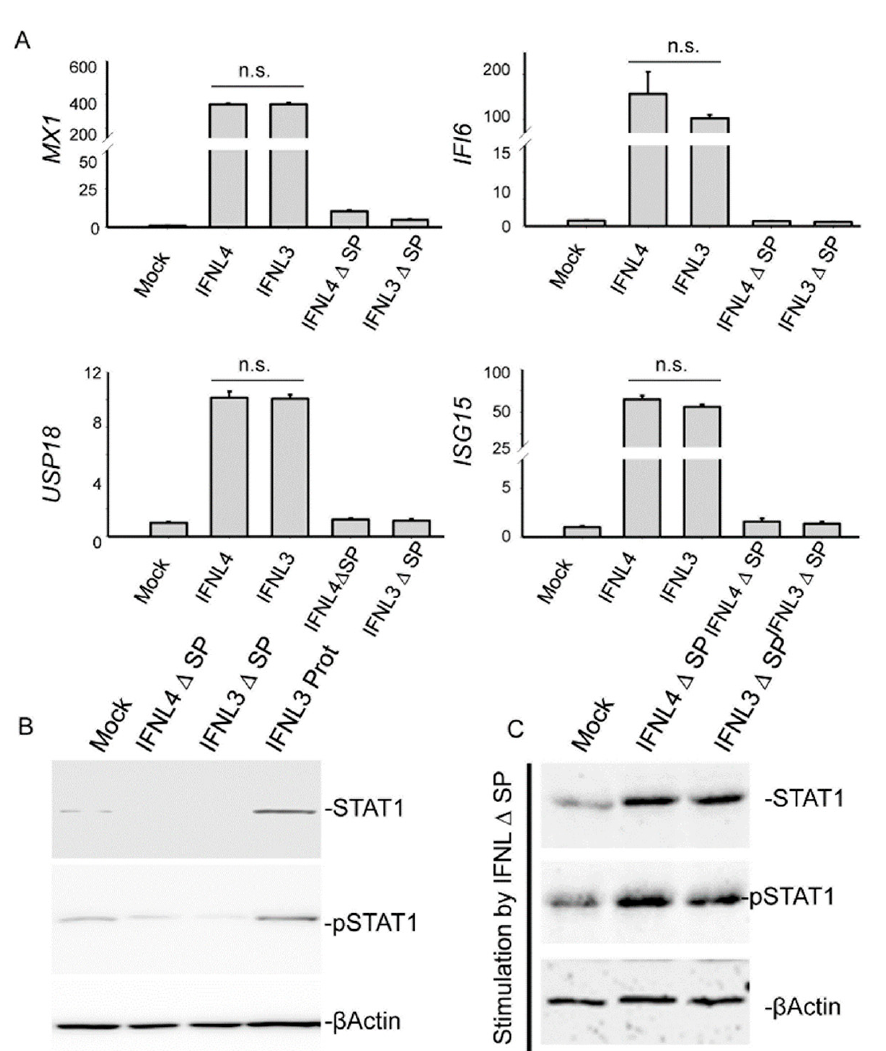
Figure 3. IFNL3 and IFNL4 do not alter JAK-STAT signaling from cytosol. ( A ) Relative expression of IFI6 , MX1 , ISG15 and USP18 was assessed by real time PCR in HuH7 cells transfected with non-tagged IFNL3 , IFNL4 , IFNL3-SP , and IFN4-SP (SP—signal peptide) for 48 h. GAPDH was used as an internal control. Transfection with empty vector was used as a mock control. The data are presented as mean ± SEM (n ≥ 4). ( B ) Immunoblot detection of STAT1 and pSTAT1 in HuH7 cells transfected with IFNL3-SP or IFNL4-SP . Transfection with empty vector was used as a mock control. Stimulation with IFNL3 protein for 24 h was used as a positive control (IFNL3 Prot). ßActin represents the loading control. Equal amounts of 4 biological replicates were loaded in each lane. ( C ) Immunoblot detection of STAT1 and pSTAT1 in HuH7 cells which were stimulated for 24 h with cell lysate obtained from cells transfected with IFNL3-SP or IFNL4-SP for 48 h. ßActin represents the loading control. Equal amounts of 4 biological replicates were loaded in each